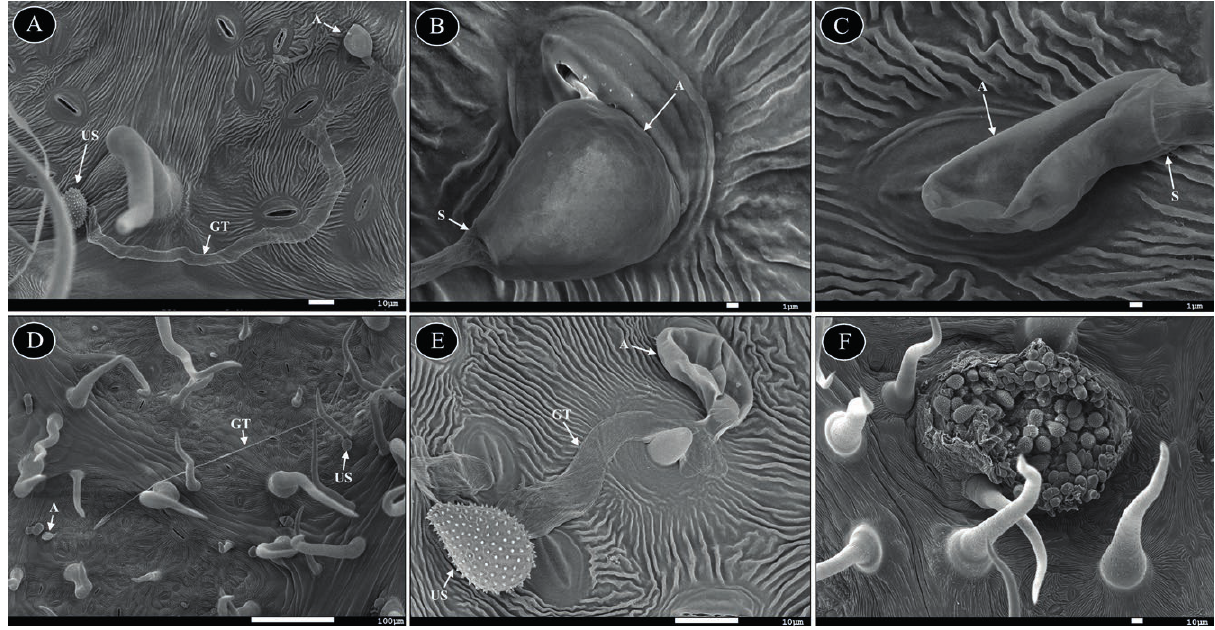
Figure 9. Scanning electron micrographs of Phakopsora nishidana on abaxial fig leaf surfaces, at 48 hpi (A and B), 96 hpi (C, D and E)